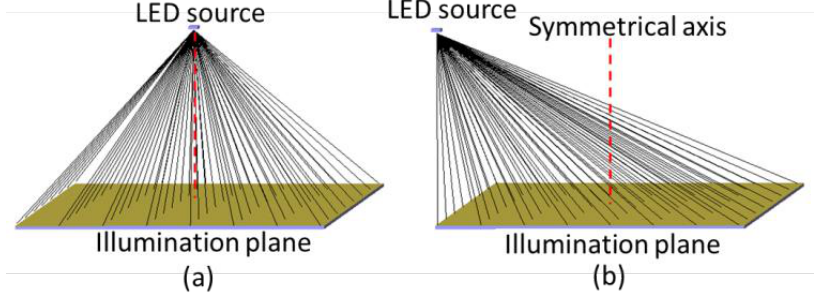
Figure 7. ( a ) The light source is on the symmetrical axis of the illumination plane and ( b ) out of the illumination plane.